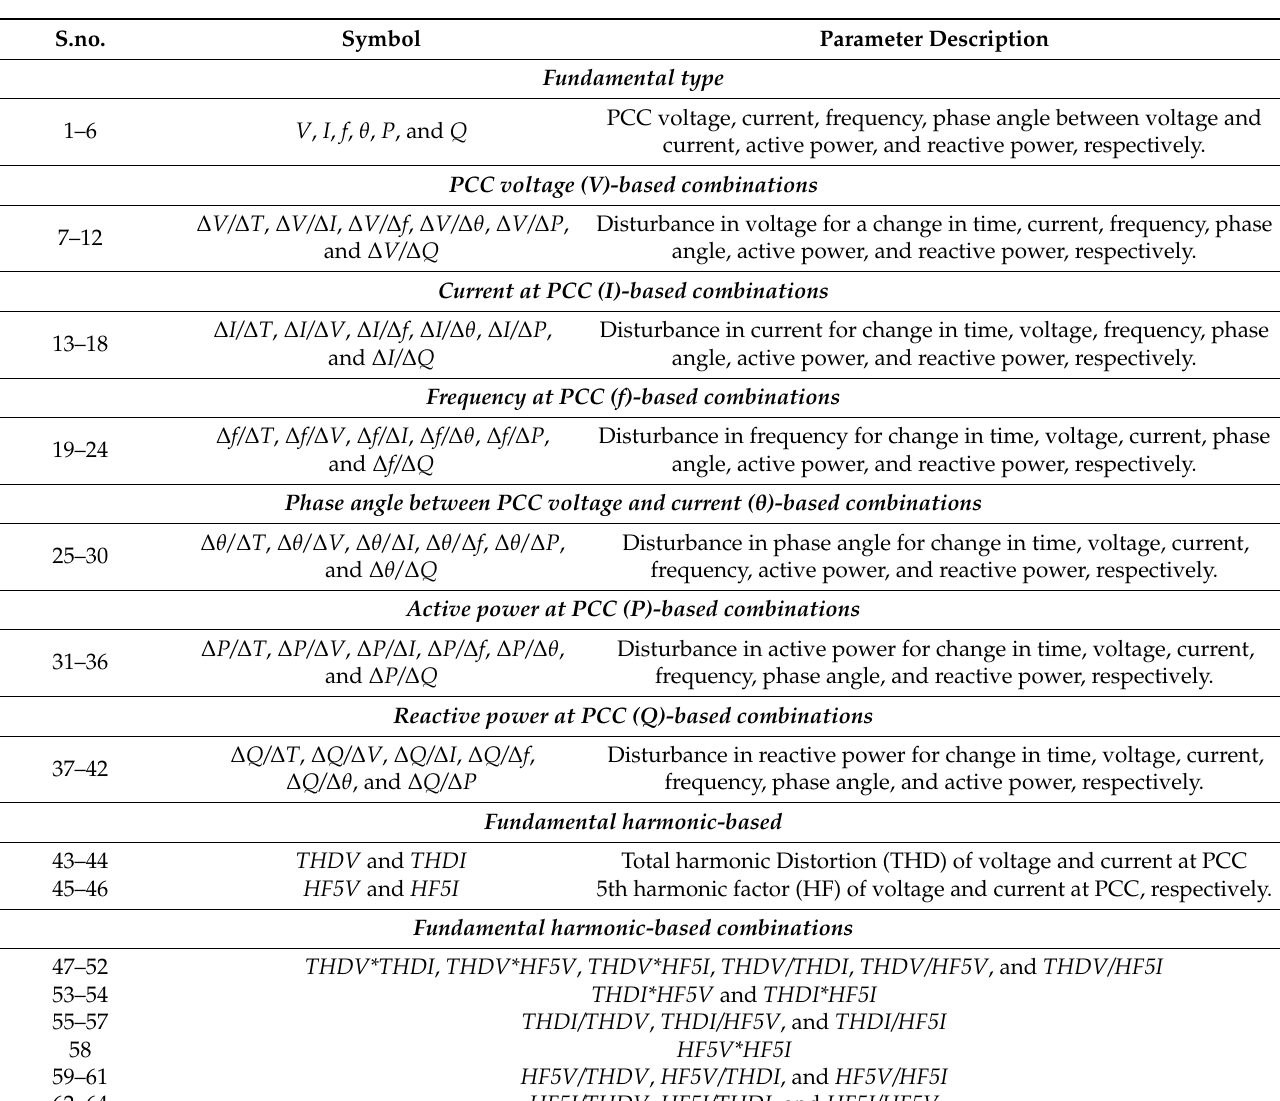
Table 1. Passive parameters